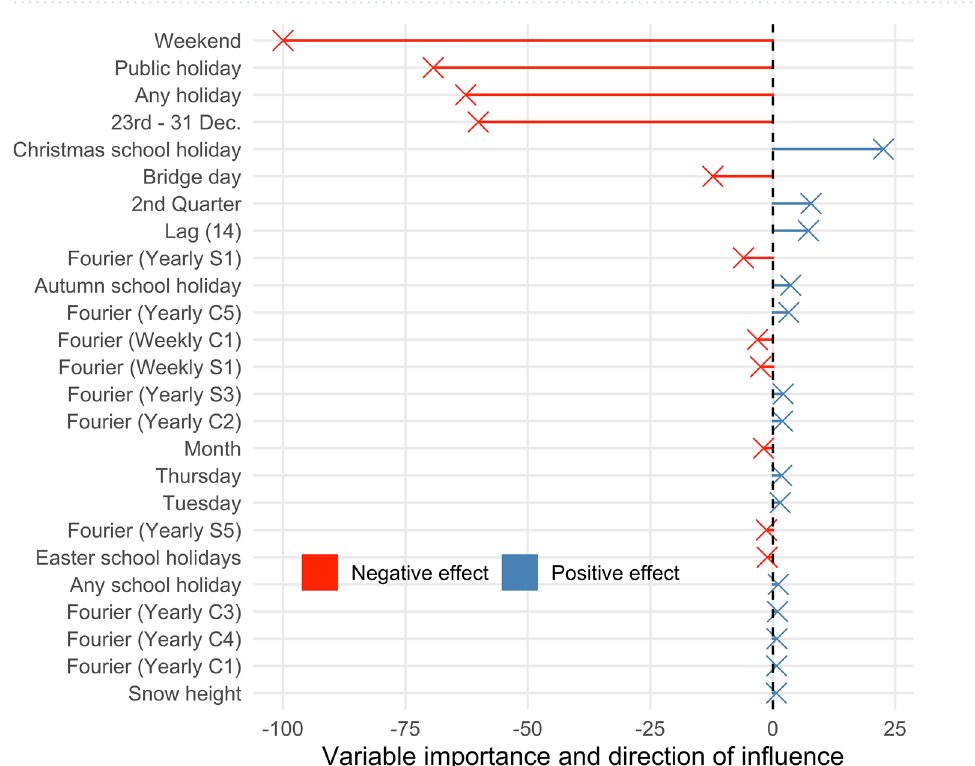
Figure 4. Variable importance of TOP 25 features in machine leaning models. Positive and negative effects represent increases and decreases in the number of admissions, respectively. Dec = December. Bridge day: Day between a holiday and the weekend, vice versa. Lag (14) = The number of admissions fourteen days before the predicted day. The Fourier series accounted to a yearly and a weekly seasonality with sine (S) and cosine (C) waves with an maximum order of 2 (weekly) and 5